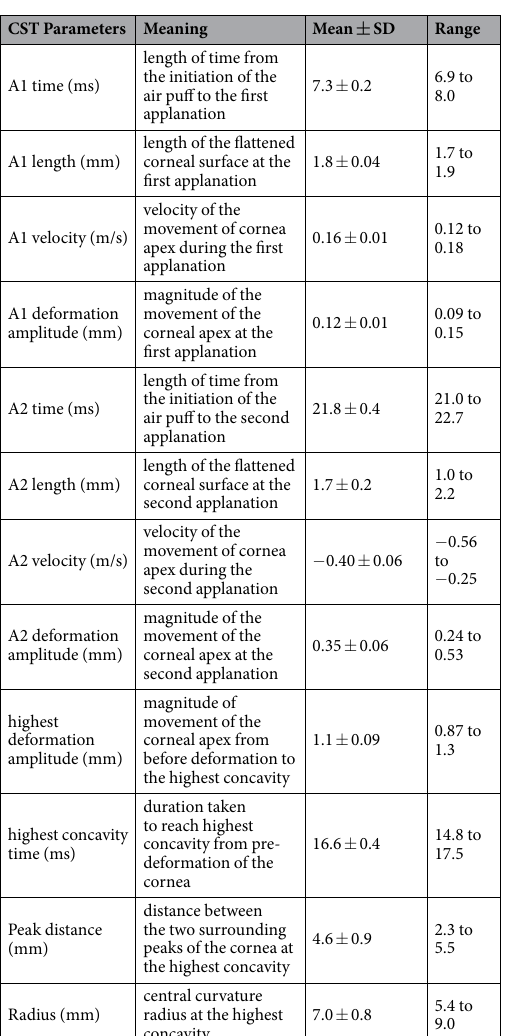
Table 1. Measured CST parameters. CST: Corvis ST tonometry, SD: standard